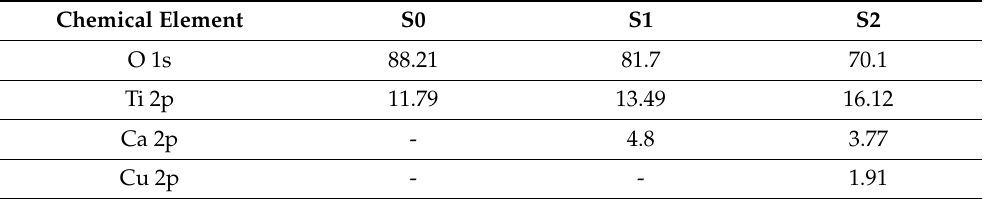
Figure 5. XPS spectra of Cu 2p 3/2 , Ti 2p, Ca 2p, and O 1s for the samples S1 and S2. Table 1. Atomic composition (%) of the surface of each